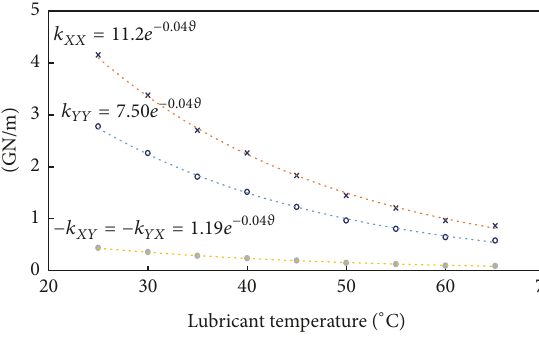
Figure 12: Variation of upper journal bearing stiffnesses with lubri- cant temperature 𝜗 (clearance condition C).